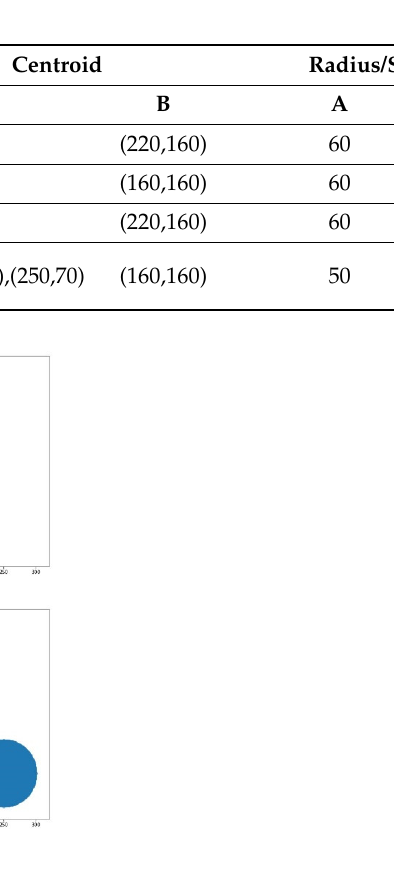
Table 2. Distance with the number of projections.